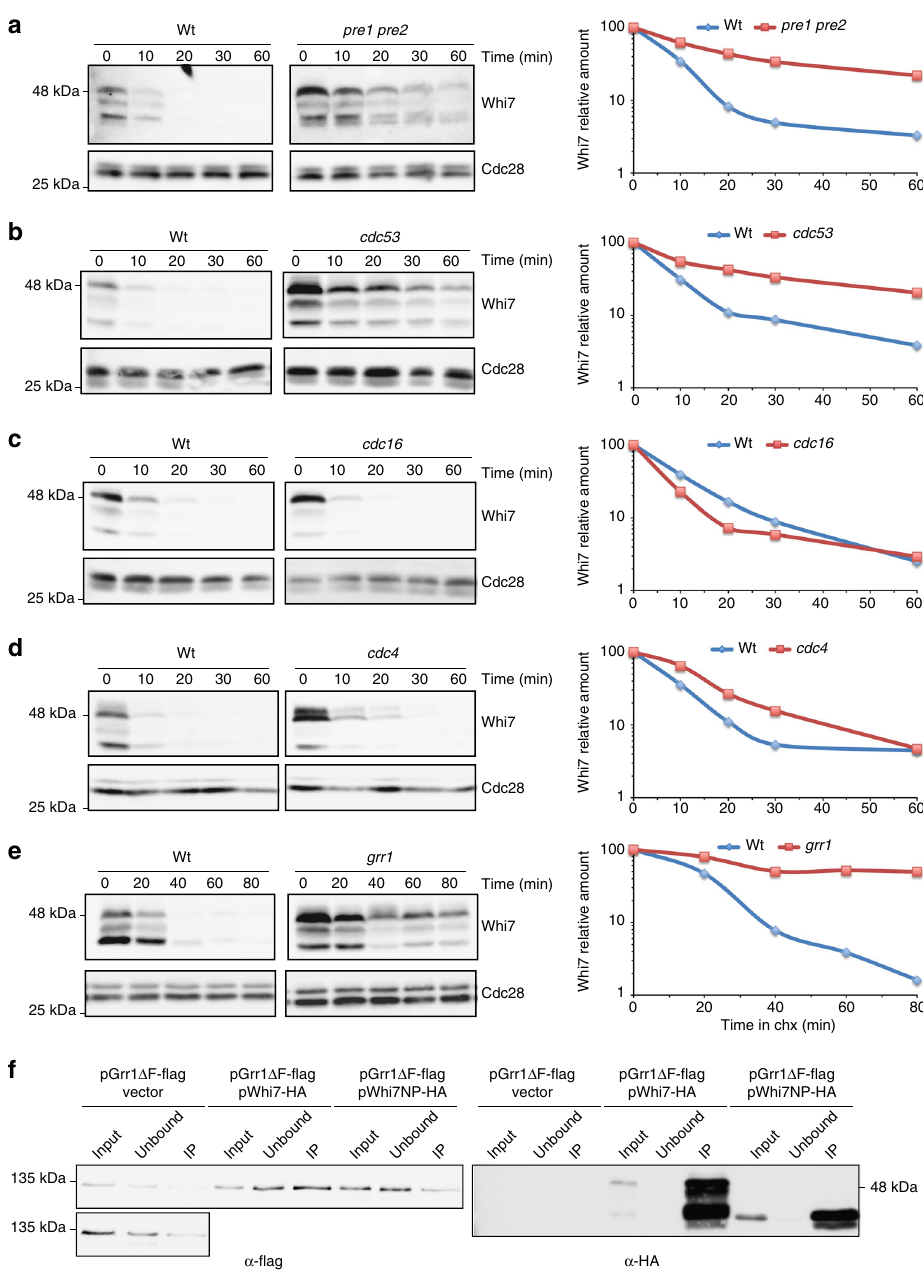
Fig. 2 Analysis of Whi7 degradation in ubiquitin-ligase mutant strains. a – e Cells of the pre1 pre2 (JCY1740) and its parental WCG4 α (JCY1739), cdc53 (JCY1732), grr1 (JCY1760), cdc4 (JCY1757) and their parental W303 (JCY1728), and cdc16 (JCY1737) and its parental A364 (JCY1735) strains expressing a HA-epitope-tagged Whi7 protein at endogenous level were transferred at 37 °C for 3 h (except the grr1 mutant and its parental strain) and then incubated in the presence of 100 μ g mL − 1 cycloheximide (chx). Whi7 protein level was analyzed at the indicated time after the addition of cycloheximide by western blot. Cdc28 is shown as loading control. Graph represents the relative amount of Whi7 protein related to Cdc28. f The grr1 mutant strain (JCY1760) was co-transformed with a plasmid expressing a fl ag-tagged Grr1 lacking its F-box (Grr1 Δ F) and either the pWHI7 or pWHI7-NP plasmid (expressing HA-tagged wild-type or a non-phosphorylatable Whi7 respectively) or a control vector. Cells were grown on raf fi nose medium and transferred to galactose medium for 4 h. Whi7 was immunoprecipitated (IP) from crude extracts and the presence of Grr1 Δ F and Whi7 in the input, unbound and immunoprecipitated fractions was determined by western analysis. A longer exposition of the vector samples is shown for better evaluate background signal the competition between cell growth and cell cycle entry for the Ydj1 chaperone 22 and the titration of increasing amounts of Cln3 molecules due to cell growth against the constant number of SBF binding sites in DNA 23 .